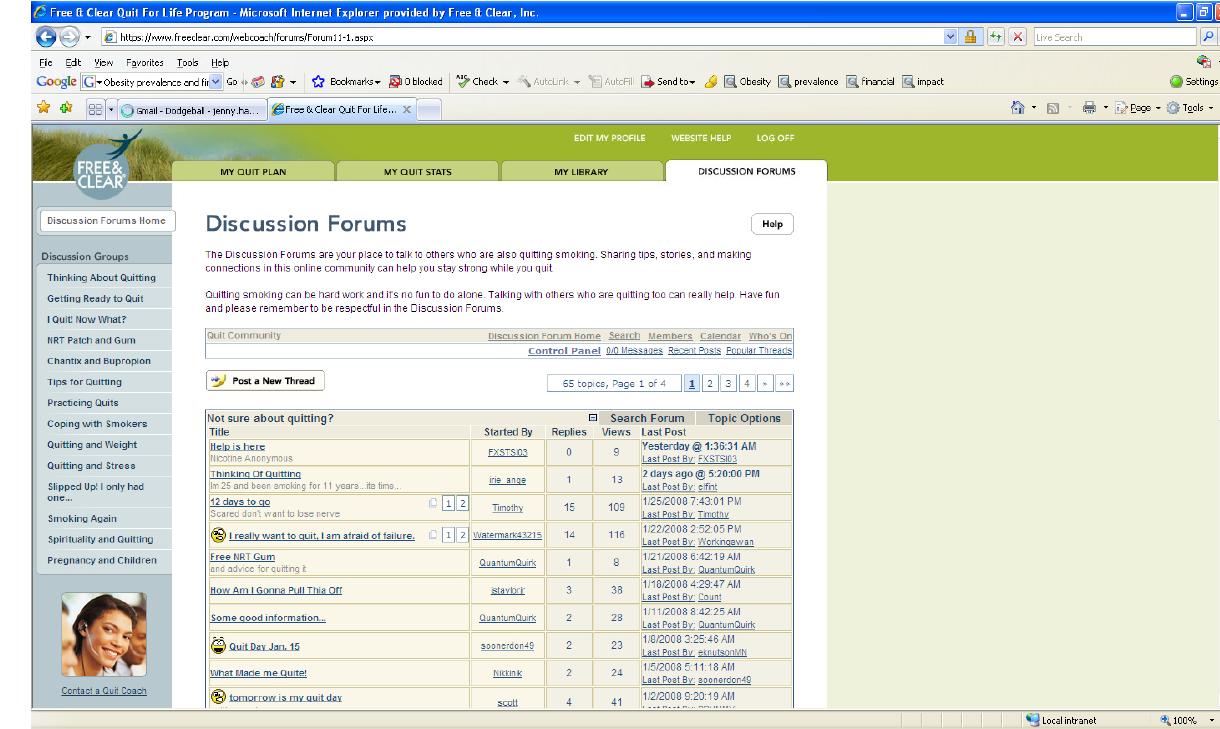
Figure 7. Discussion forum